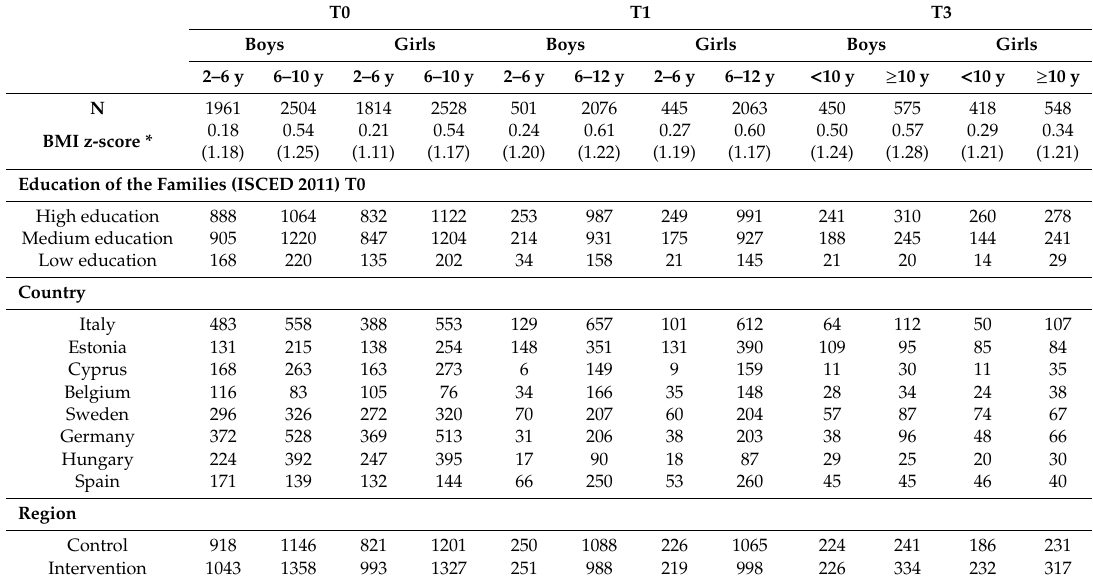
Table 1. Descriptive characteristics of the children participating in the di ff erent surveys T0, T1, and T3. T0 T1